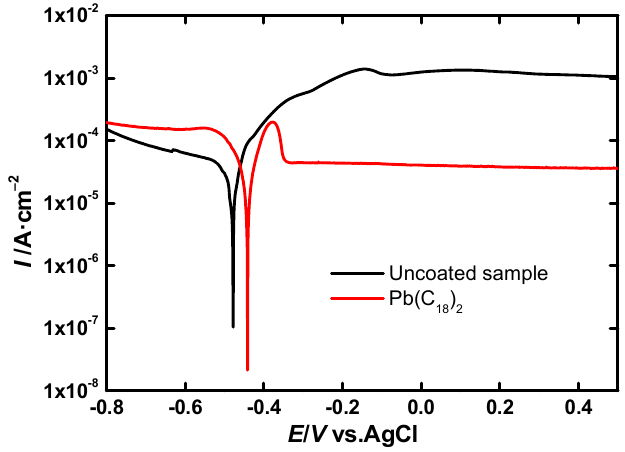
Figure 5. Potentiodynamic curves in a 0.1 M TBAB solution containing 5 µg·L −1 acetic acid at a scan rate 3 mV·s −1 of lead samples coated in a 50 mM NaC 18 solution for 24 h.